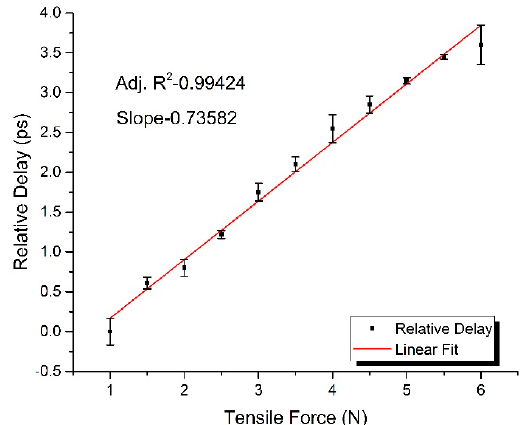
Figure 2. The experimental response of relative delay for the rise of the longitudinal tensile force.